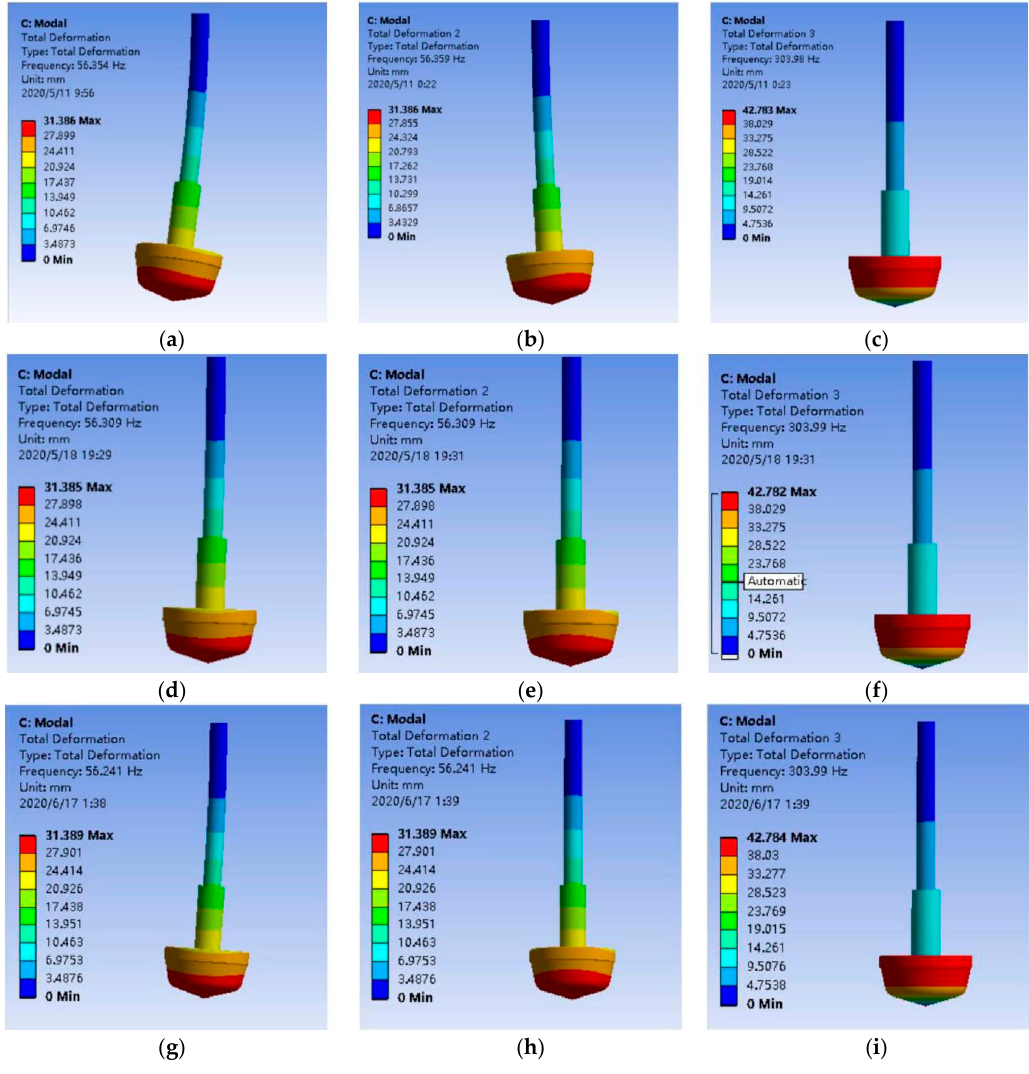
Figure 12. Vibration mode diagrams for the first, second, and third order modes at valve openings of 2%, 15%, and 60%; ( a ) First-order mode at 2% opening; ( b ) Second-order mode at 2% opening; ( c ) Third-order mode at 2% opening; ( d ) First-order mode at 15% opening; ( e ) Second-order mode at 15% opening; ( f ) Third-order mode at 15% opening; ( g ) First-order mode at 60% opening; ( h ) Second-order mode at 60% opening; ( i ) Third-order mode at 60%